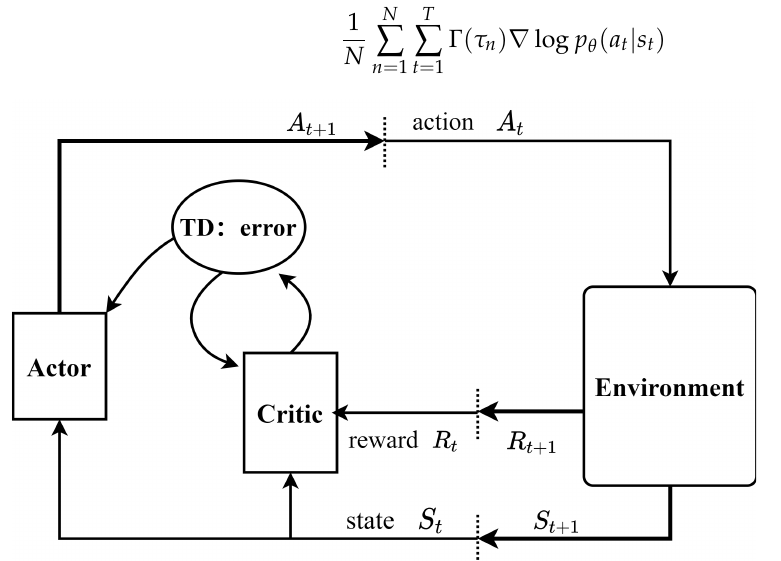
Figure 4. Actor–Critic